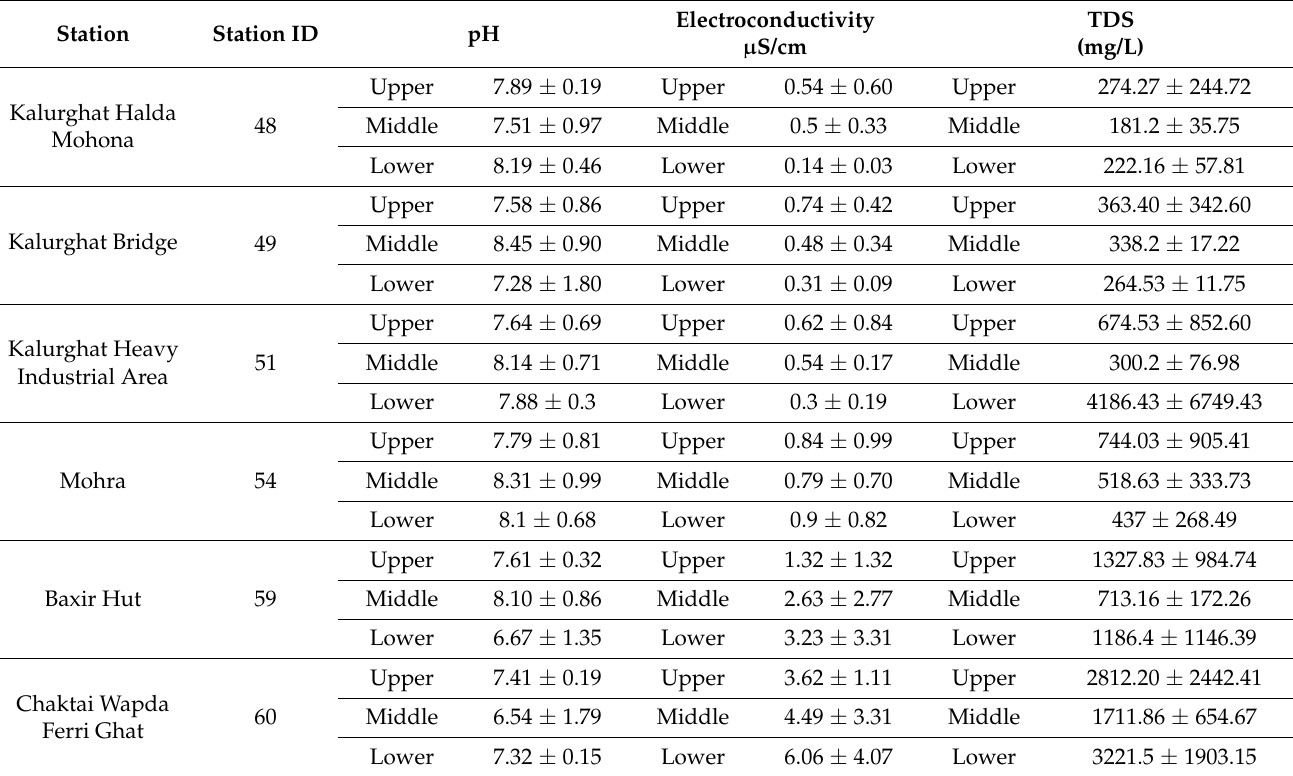
Table 3. Observed water quality parameters (mean ± standard deviation) in different locations of the Karnafuli